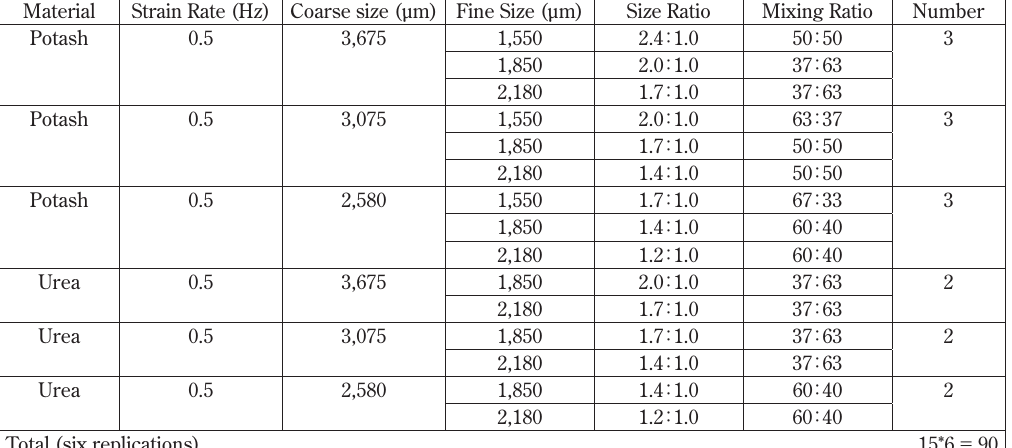
Table 4 Validation design for binary size mixtures for potash and urea